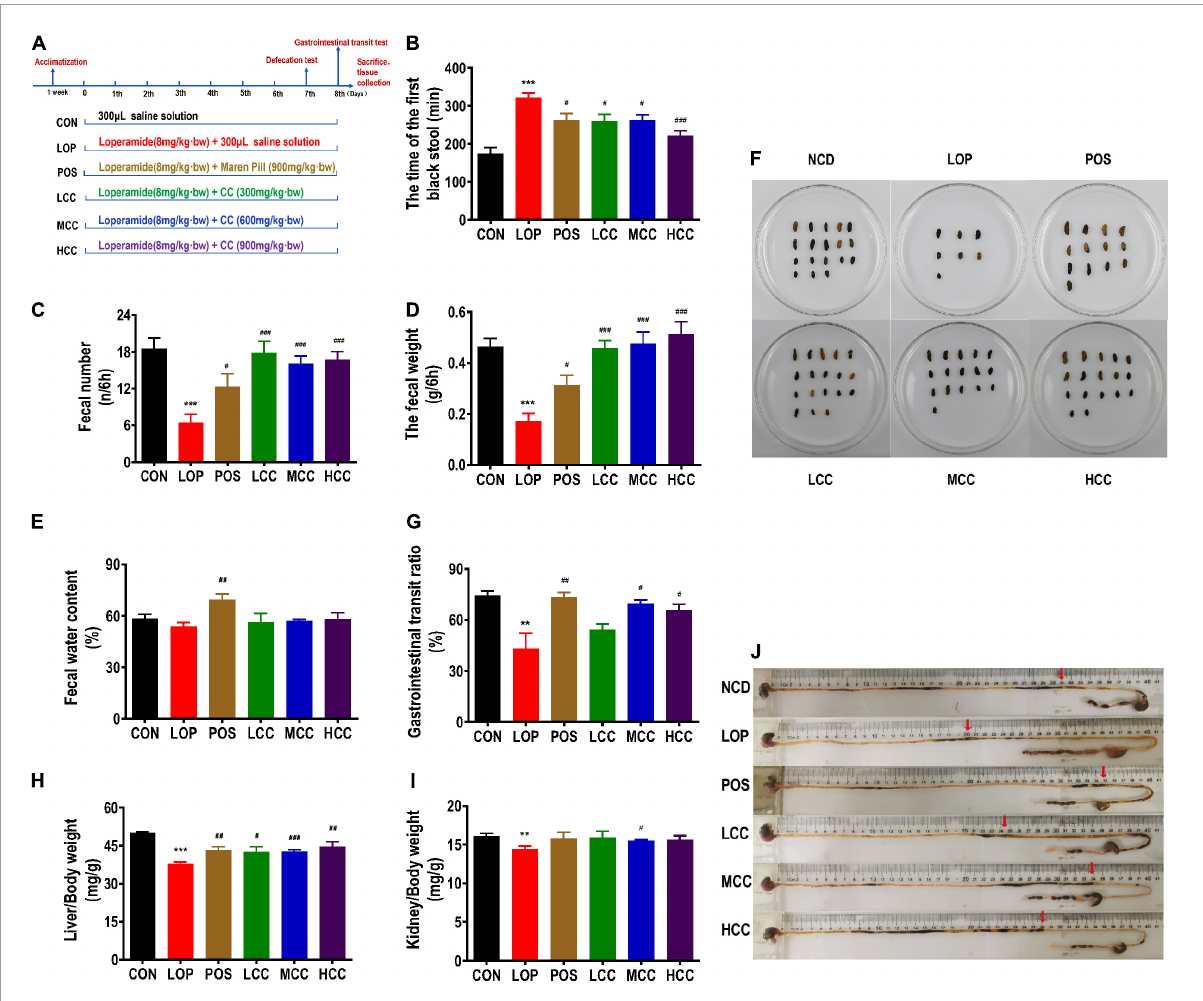
FIGURE1 Influences of CCAE on loperamide-induced constipation symptoms in mice. (A) Grouping and basic workflow of animal experiment. (B) The defecation time of the first black stool, FBS. (C) Number of feces excreted in 6 h, FN. (D) Wet weight of feces excreted in 6 h, FW. (E) Fecal water content. (F) Representative fecal morphology of each group. (G) Gastrointestinal transit rate, GTR. (H) Liver index. (I) Kidney index. (J) Ink advancing distance and intestinal length. The data are expressed as the means ± SEMs ( n = 10-12). *, Compared with the CON group; #, compared with the LOP group. ** P < 0.01, *** P < 0.001. # P < 0.05, ## P < 0.01, ### P <